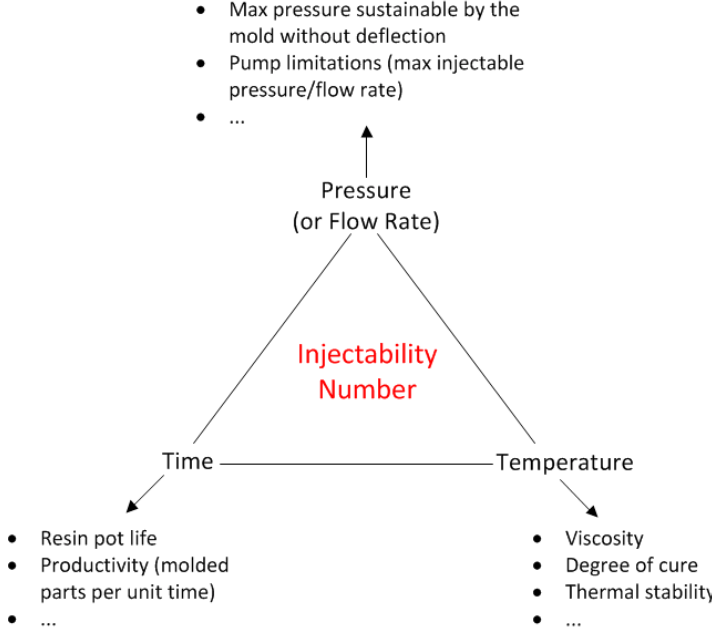
Figure 1. Injectability number, main process variables, and technological constraints.